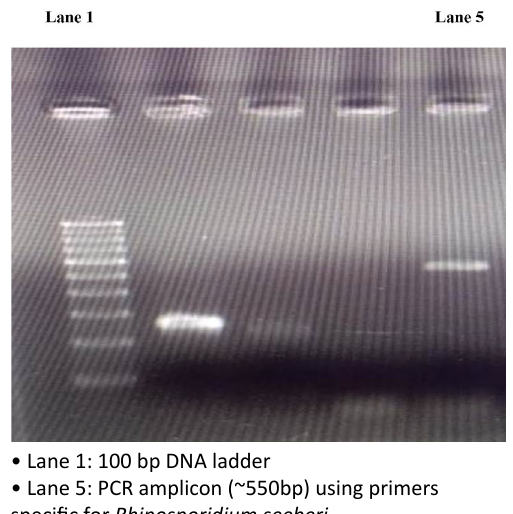
Fig. 2. Gel electrophoresis image of the PCR